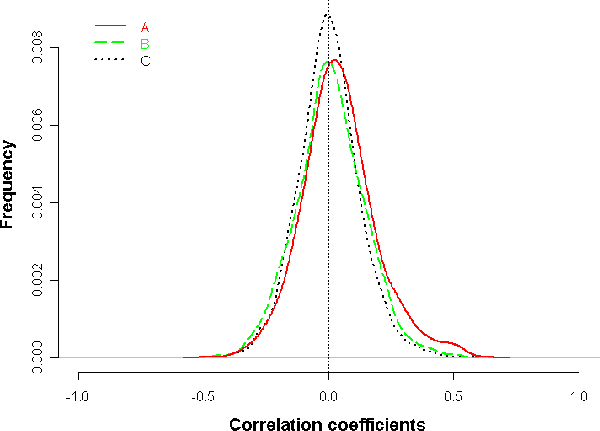
Distribution of Pearson correlation coefficients. (A) The distribution of correlation coefficients of bidirectional genes average over 46 microarray data sets. (B) The distribution of correlation coefficients of neighboring genes average over 46 microarray data sets. (C) The distribution of correlation coefficients of randomly paired genes average over 46 microarray data sets. Bidirectional gene pairs are more correlated in expression than randomly paired genes (P < 2.2 × 10-16 by the Wilcoxon rank sum test) and neighboring gene pairs (P = 1.17 × 10-11).